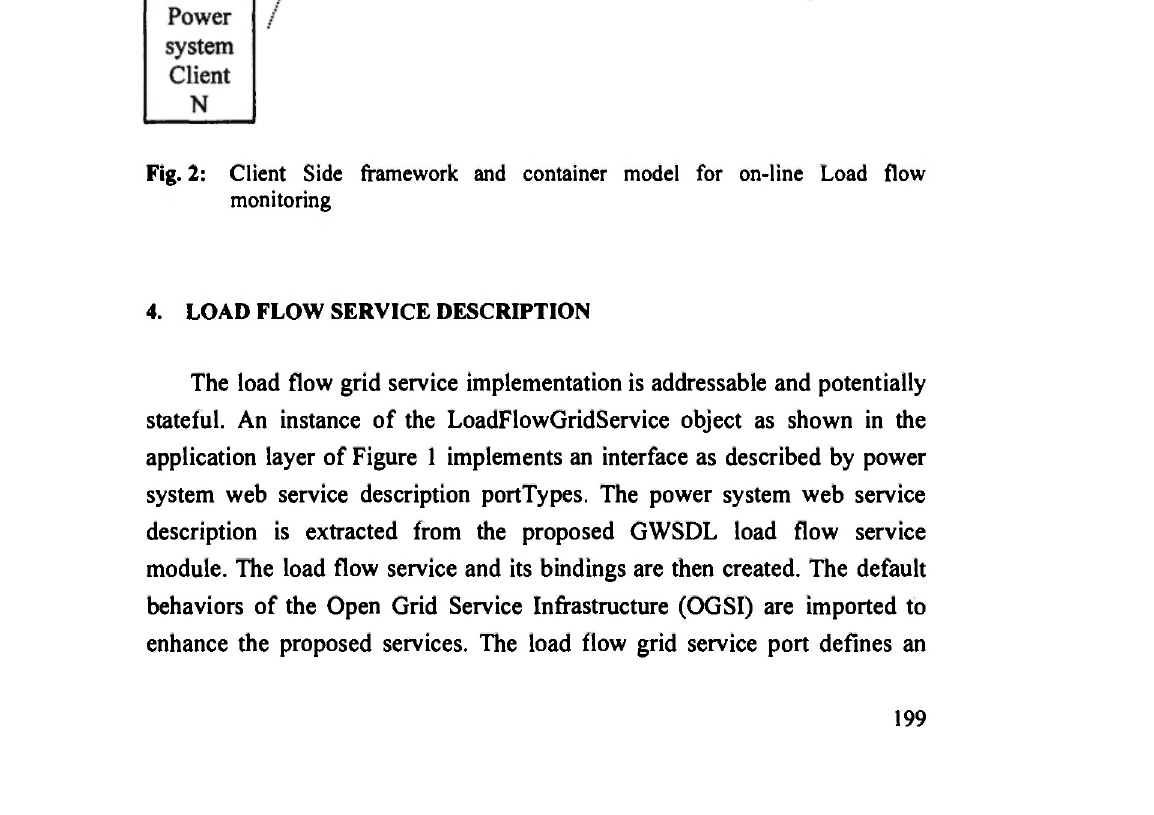
Fig. 2: Client Side framework and container model for on-line Load flow